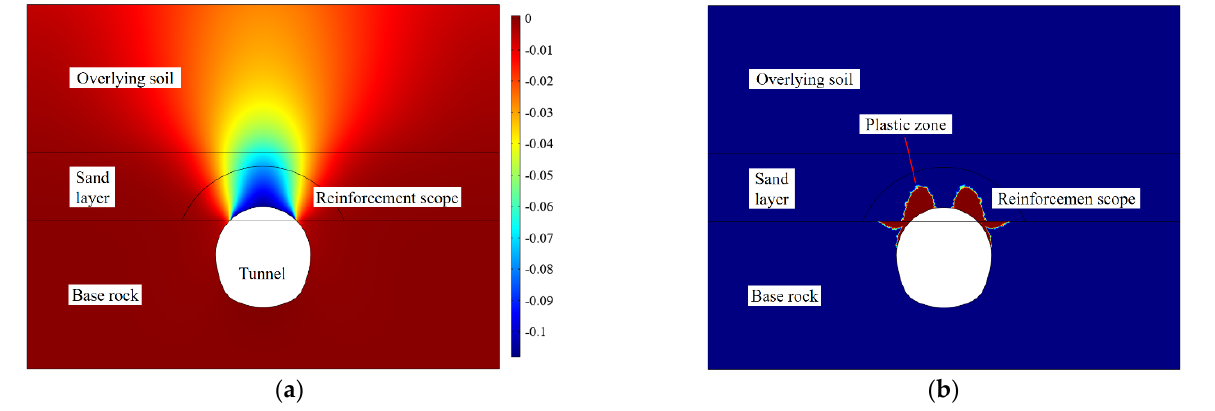
Figure 18. Calculation results of tunnel stability. ( a ) Settlement distribution (unit: m). ( b ) Distribution of plastic zone.